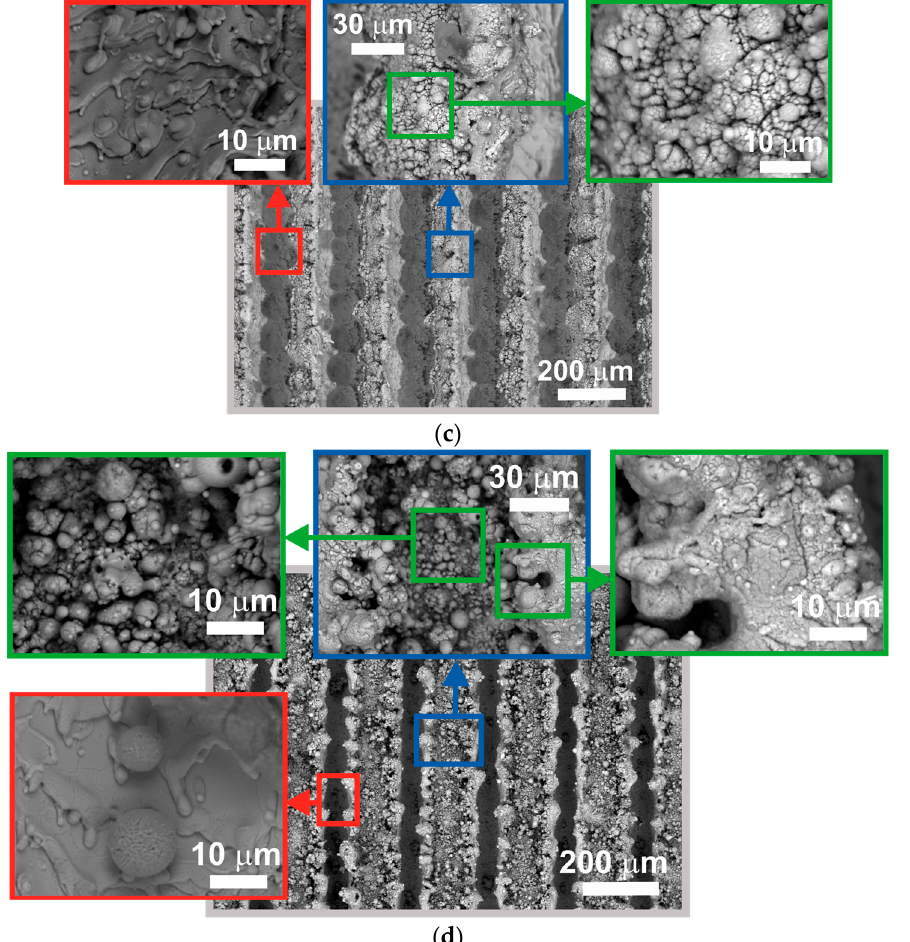
Figure 6. SEM images of polished ( a ) and laser-modified steel surfaces. ( b ) AB, ( c ) A2B, and ( d ) 2AB. The gray frame represents a typical area on the surface. The red frame represents the textured area after processing by laser radiation. The green and blue frames represent the non-textured areas. Table 2. The 3D roughness parameters of steel